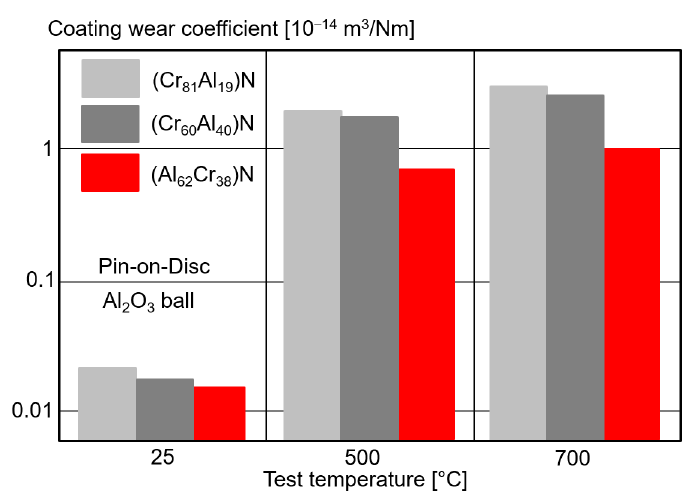
Figure 15. Wear coefficient of (CrAl)N and (AlCr)N coatings with different Al contents by pin-on-disc 15 tests compared to Al 2 O 3 balls for different test temperatures, redrawn after [83], original © Springer